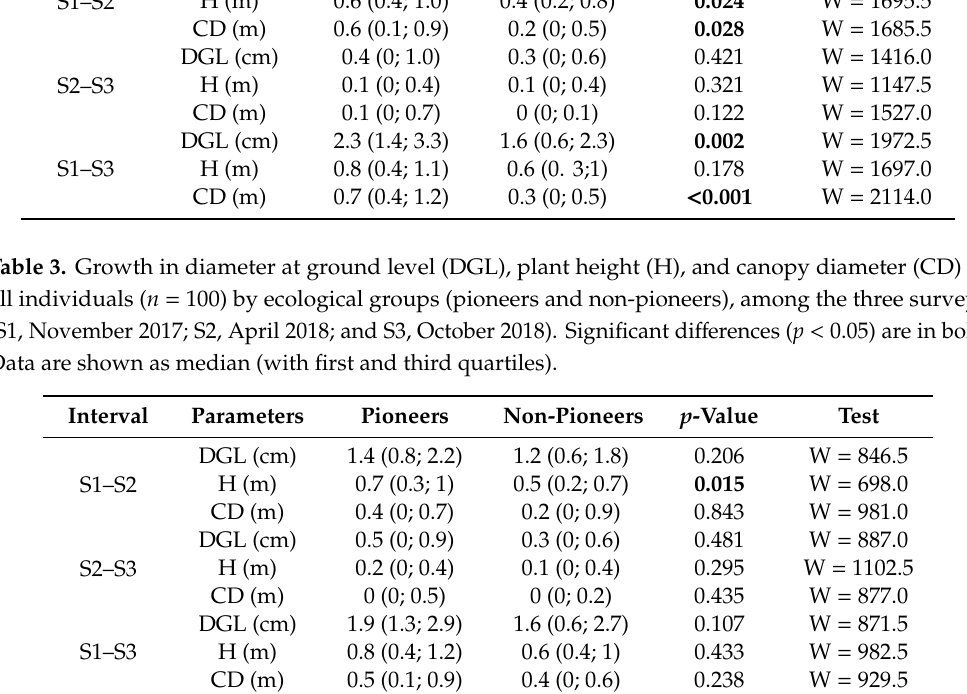
a ff ect the number of regenerating morphospecies ( ρ = 0.146; p = 0.424; Figure 2A); however, on S2, there was an inverse association between grass cover and regenerating morphospecies richness ( ρ = − 0.443; p = 0.011; Figure